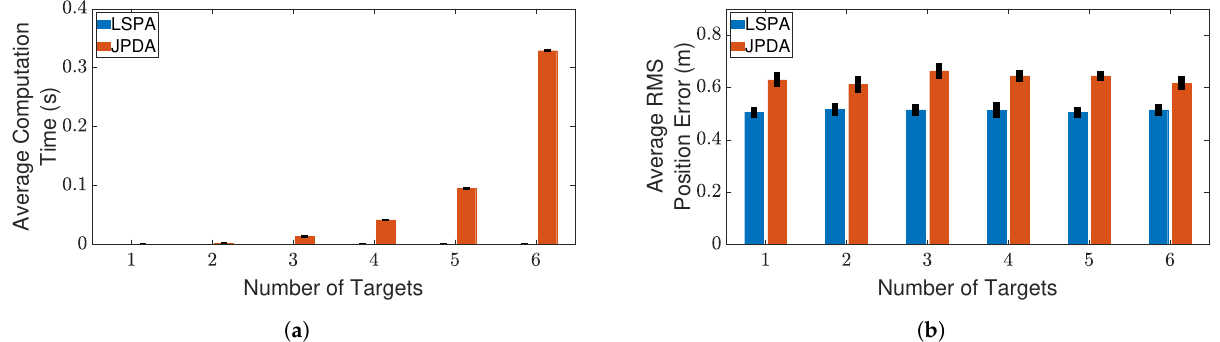
Figure 7. Tracking multiple crossing targets using LSPA and JPDA with clutter density λ = 1 × 10 − 4 /m 2 . ( a ) Average computation time for obtaining association probabilities; ( b ) average RMS position error. Error bars indicate 95% confidence intervals.